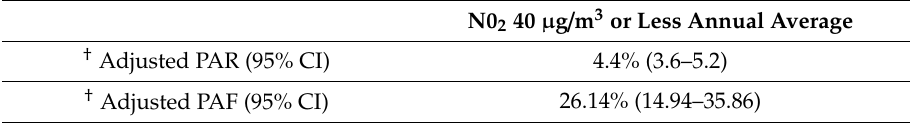
Table 5. Population attributable risk (PAR) and population attributable fraction (PAF) of nitrogen dioxide 3-year annual moving